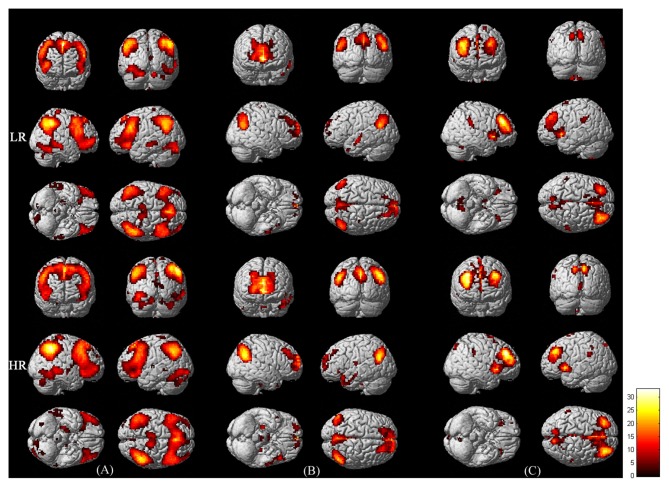
Functional connectivity maps of the central executive network (CEN; A) default mode network (DMN; B) and salience network (SN; C) in LR (upper panel) and HR (lower panel) groups. The maps were derived from the one-sample t-test of Group independent component analysis (ICA; p < 0.001, corrected by family wise error (FWE)). Bar at the right shows T-values.